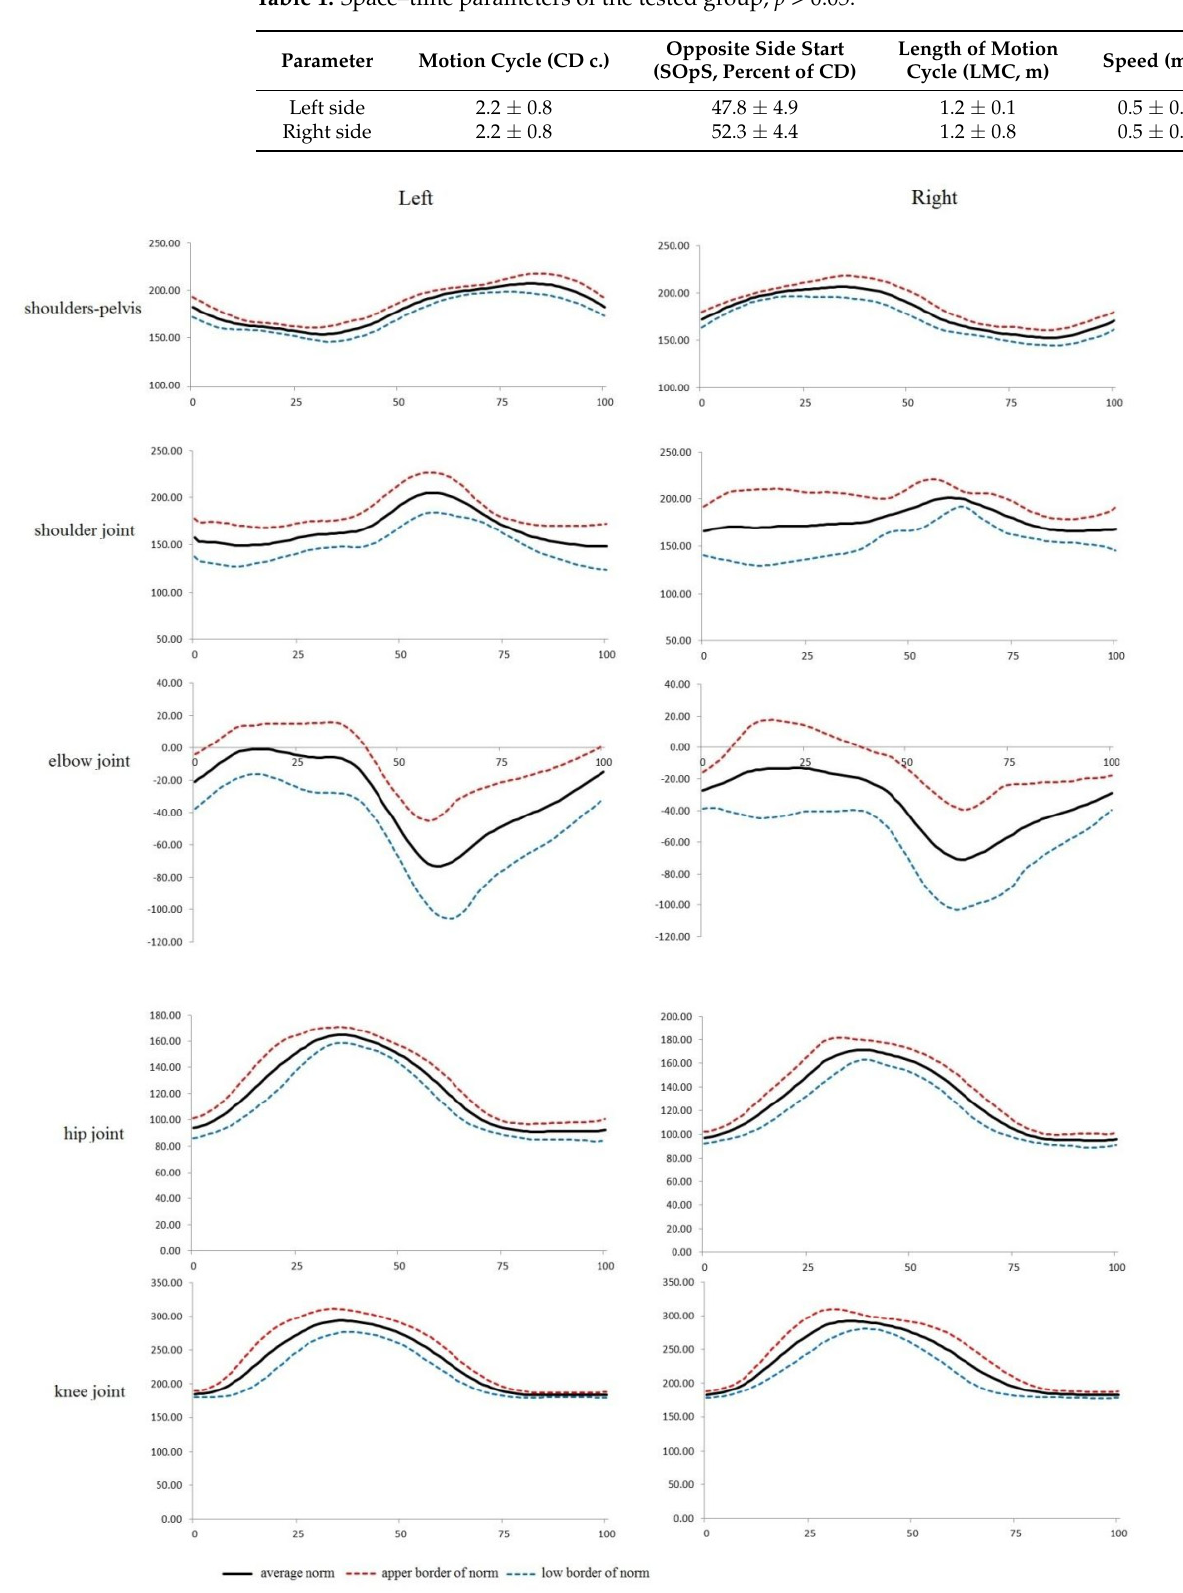
Figure 5. Diagrams of activity in joints and body motions on the left and right side in crawling. Horizontally—motion cycle in percentage, vertically—angle in degrees.